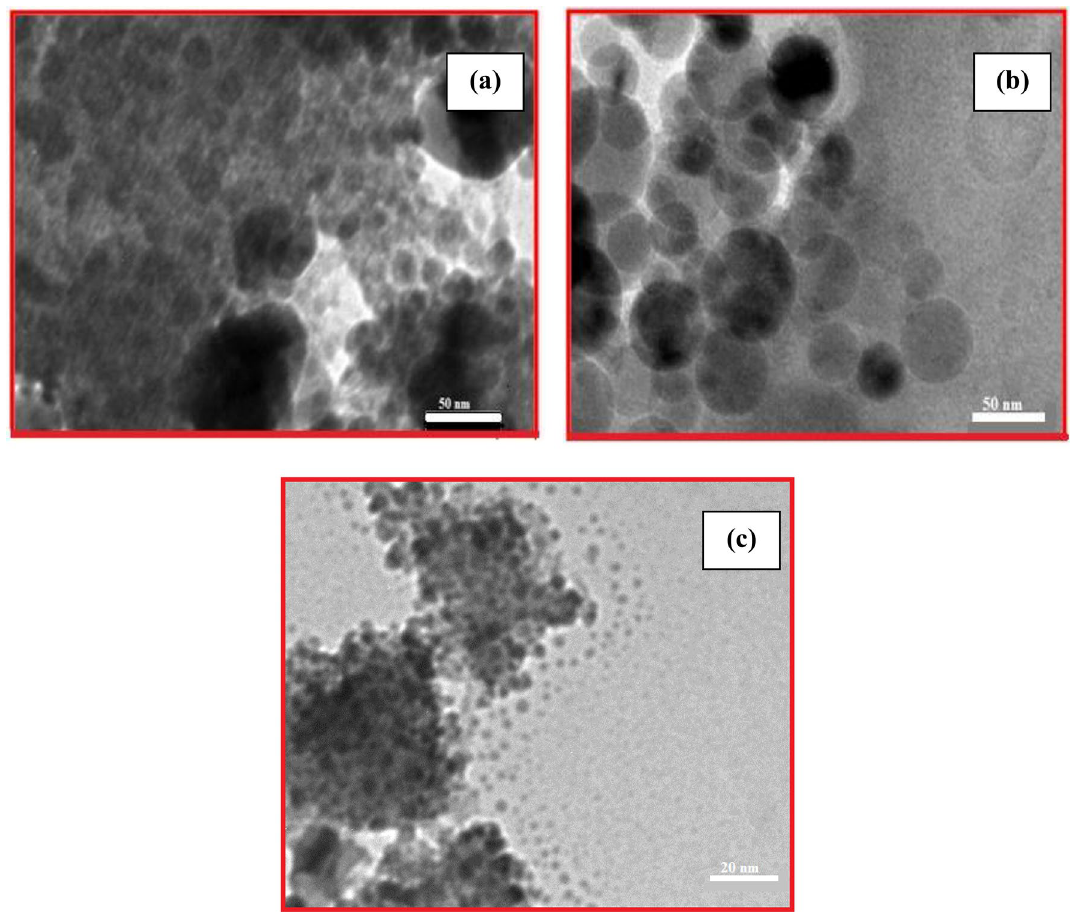
Figure 3. TEM picture of ( a ) CT ( b ) CS-CT and ( c ) AS-CT